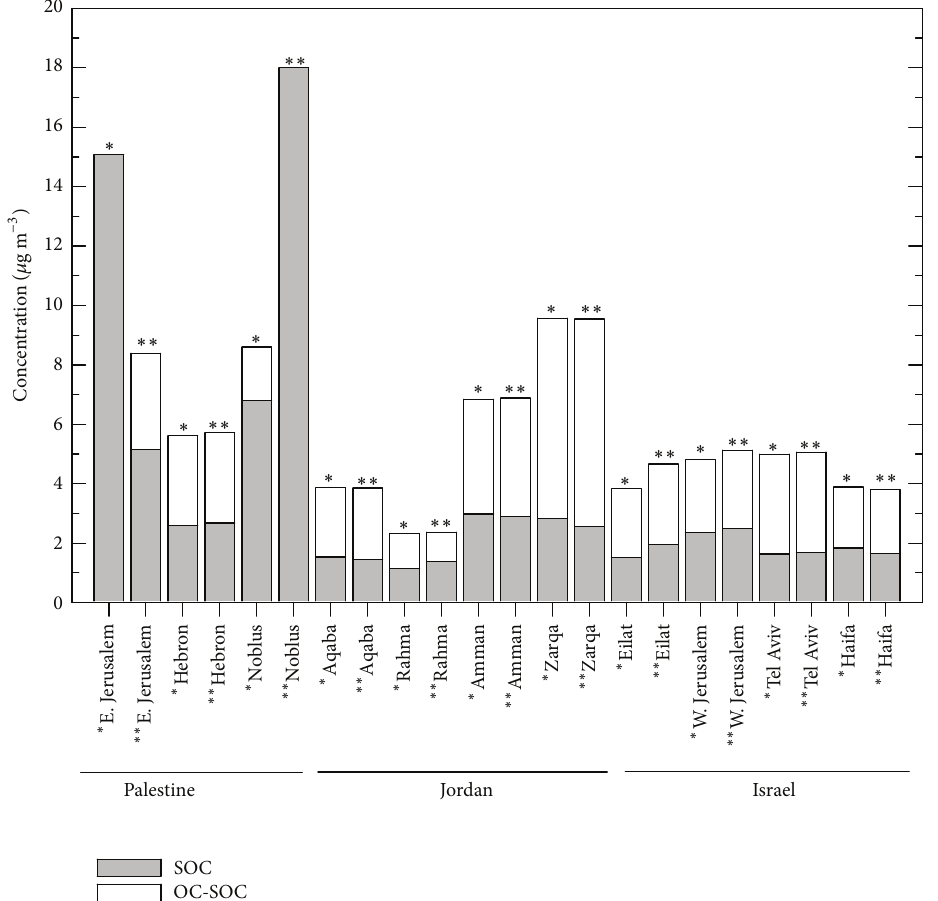
Figure 6: Calculated secondary organic aerosol during the study period ( ∗ ; lowest 5% of OC/EC ratio for Deming regression ( 𝑛 = 4 for each site), ∗∗ ; lowest 10% of OC/EC ratio for Deming regression ( 𝑛 = 6 for each site)).